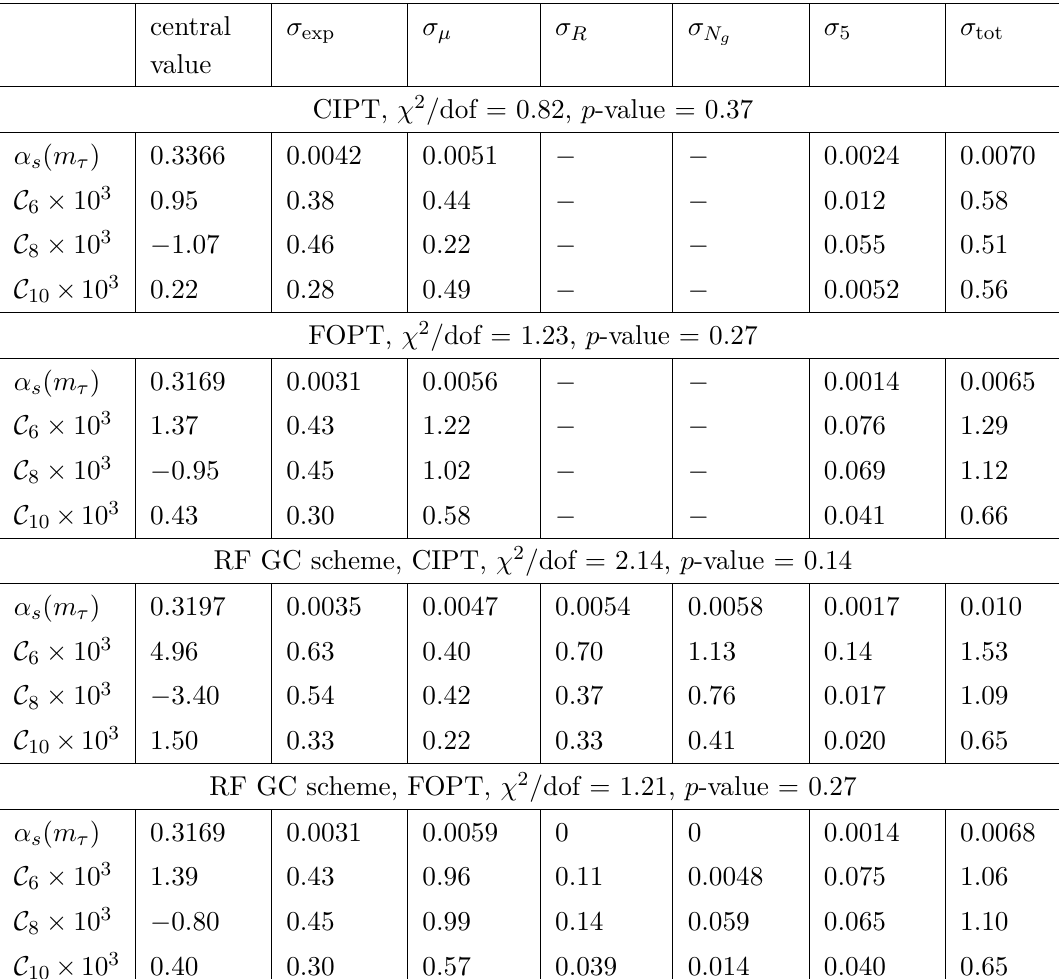
Table 3 . Fitted parameters from the ALEPH V + A spectral function used in ref. [11] for CIPT and FOPT in the MS GC scheme and in the RF GC scheme. For the latter we use N g = 0 . 57 ± 0 . 23 . The uncertainty σ 5 reflects the variation of the 6-loop coefficient as in eq. (2.15), while σ µ and σ R refer to variations of the strong-coupling renormalization scale µ and of the IR subtraction scale R as described in the text. The values for σ µ , σ 5 , σ R , and σ N are half the difference between g the maximum and minimum values obtained from the ξ , c 5 , 1 , R , and N g variations, respectively, using the central values for the remaining parameters. The two zeros in the lowest section refer to numbers smaller than 10 − 5 . The C k are given in units of GeV k and are denoted O k in ref. [11].